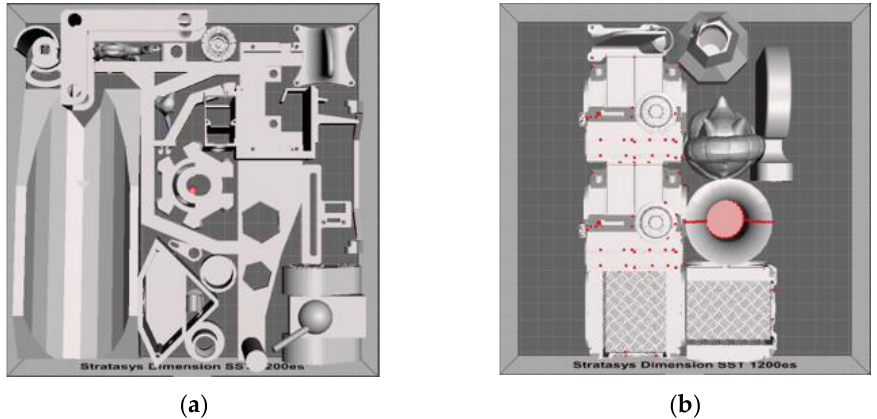
Figure 9. Nesting layouts for the dataset from [31] using the proposed method: ( a ) The first batch; ( b ) the second batch.